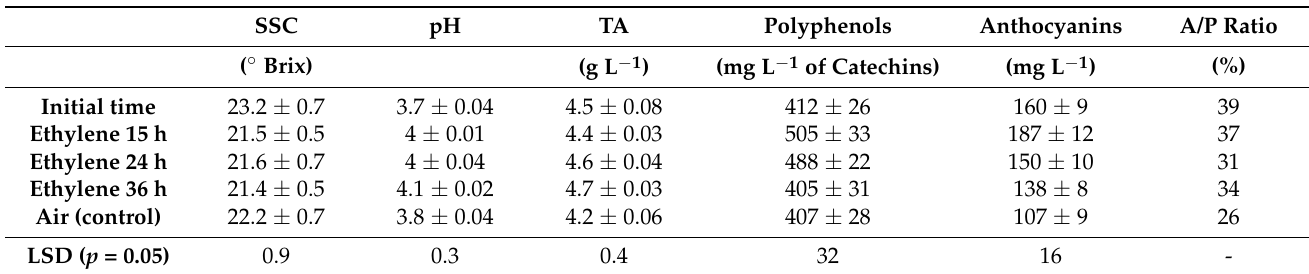
Table 2. Initial and final (36 h) values of soluble solids content (SSC) ( ◦ Brix), pH, titratable acidity (TA), total polyphenols, total anthocyanins, and anthocyanins/polyphenols (A/P) ratio in ethylene- (15, 24, and 36 h) treated samples over air- treated one. Data are the means of the berries picked from three different bunches each sampling (30 berries for SSC, 3 reps for the remaining analyses). Mean separation was performed by applying least significant difference (LSD)